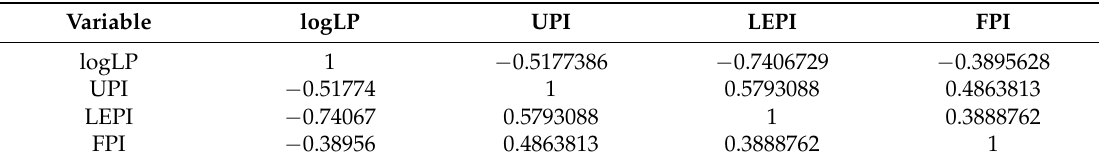
Table 4. Correlation test (Source: Authors’ elaboration).